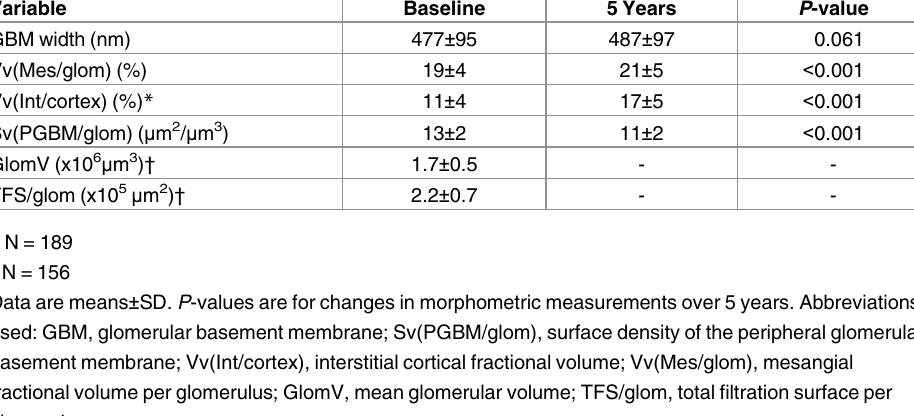
Table 2. Renal structural characteristics of the 243 participants in RASS with type 1 diabetes who had plasma bradykinin and related peptides measuredat baseline. Variable Baseline 5 Years P -value GBM width (nm) 477 ± 95